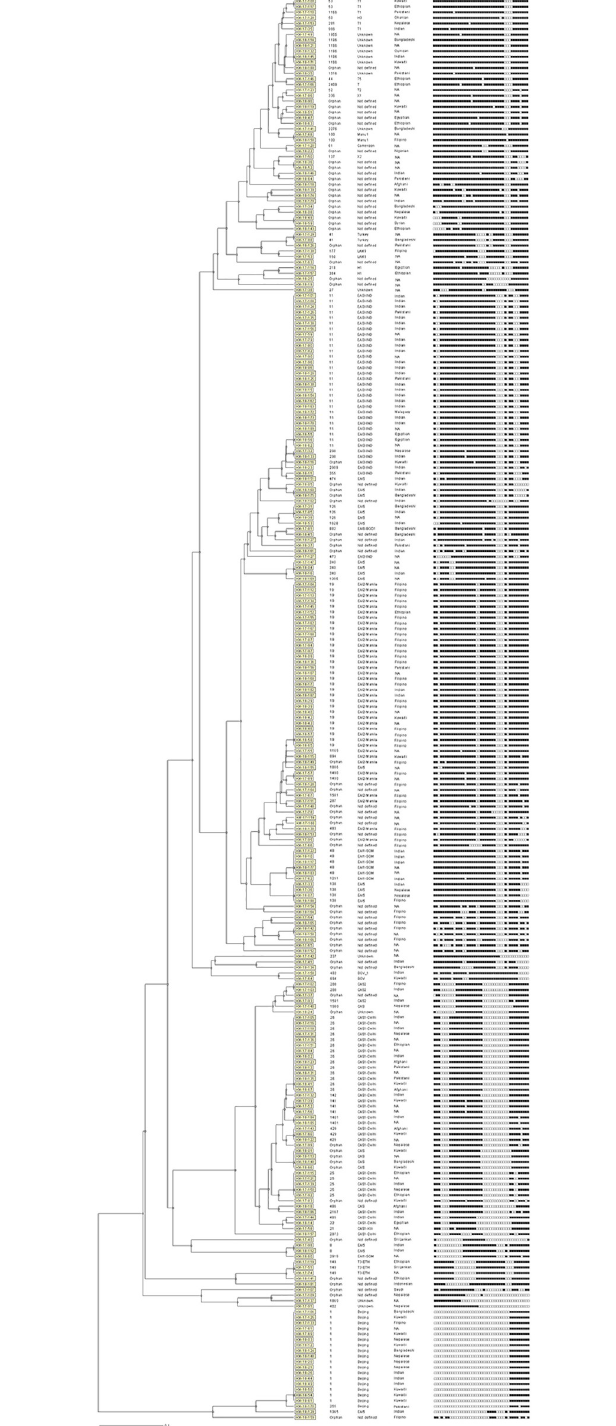
PLOS ONE | https://doi.org/10.1371/journal.pone.0276487 October 20,